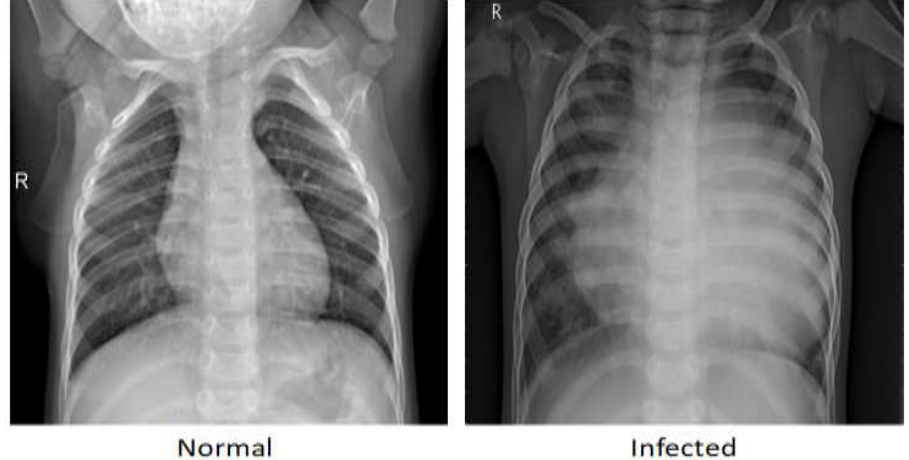
Figure 4. Examples of normal and of pneumonia-infected lungs.